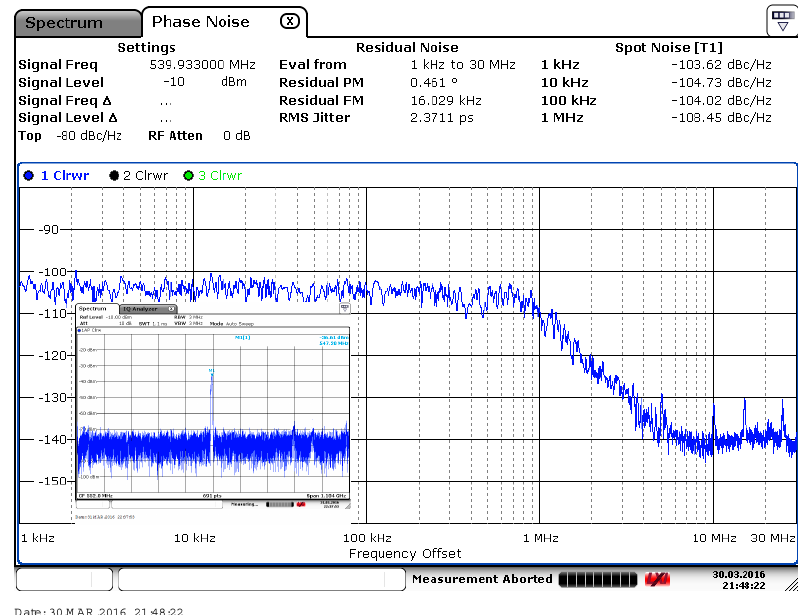
Figure 8. Measured phase noise of proposed VCO at 540 MHz carrier.